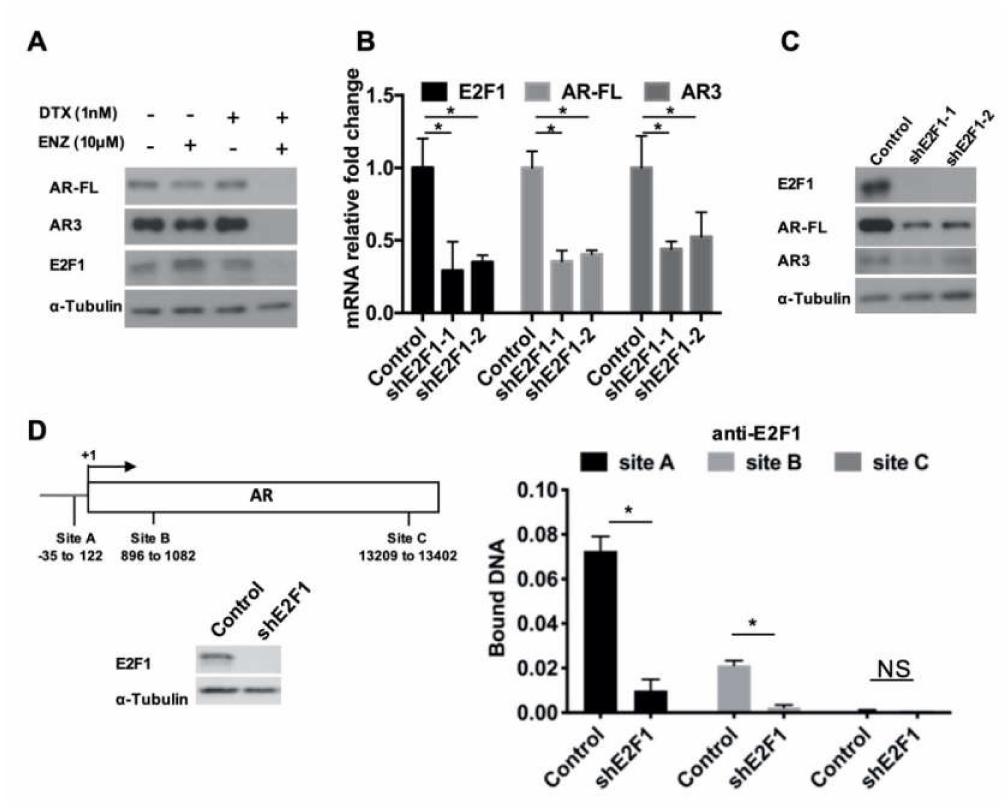
Figure 5. E2F1 regulated AR expression. ( A ) AR-FL, AR3, and E2F1 protein level 4 days after DTX + ENZ treatment were determined by western blot. ( B , C ) R1-ADR cells were infected with the lentivirus encoding the control shRNA or E2F1 shRNA for 48 h. Expression level of E2F1, AR-FL, and AR3 were determined by qRT-PCR ( B ), Error bars, S.D. * p < 0.05 and western blot ( C ). ( D ) Binding of E2F1 to the regulatory regions of AR was analyzed by ChIP